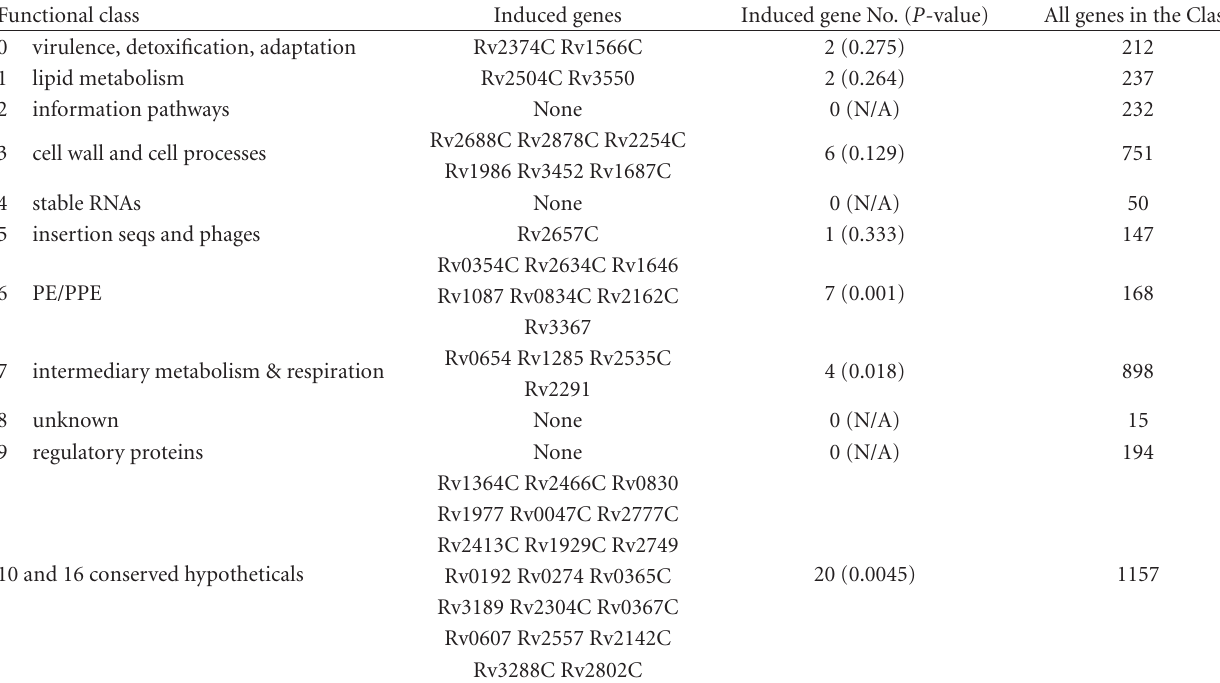
Table 3: Functional classes of genes strongly induced by capreomycin and PA-824 relative to other TB drugs. P = the chance probability of the number of the genes identified from a given functional category among all genes. Functional classes are based on TubercuList